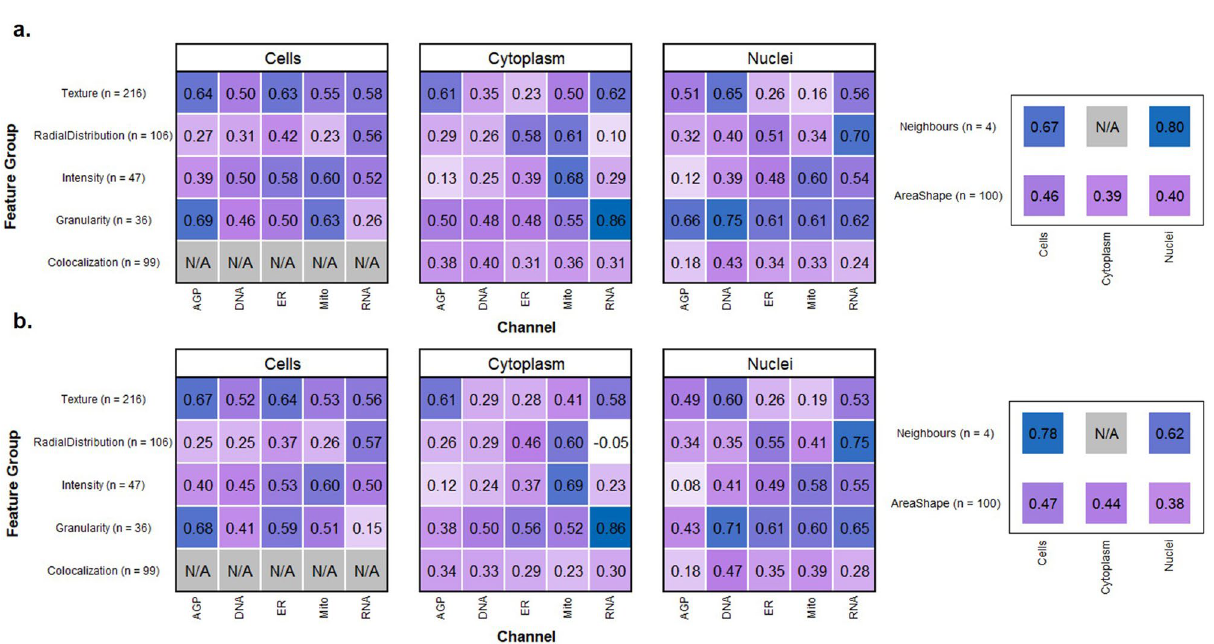
Figure 4. Colored composite image of three channels from the test dataset (Table 1): AGP (red), ER (green) and DNA (blue). ( a ) Ground truth. ( b ) cWGAN-GP model output. ( c ) U-Net model output. Each image is 512 × 512 pixels.